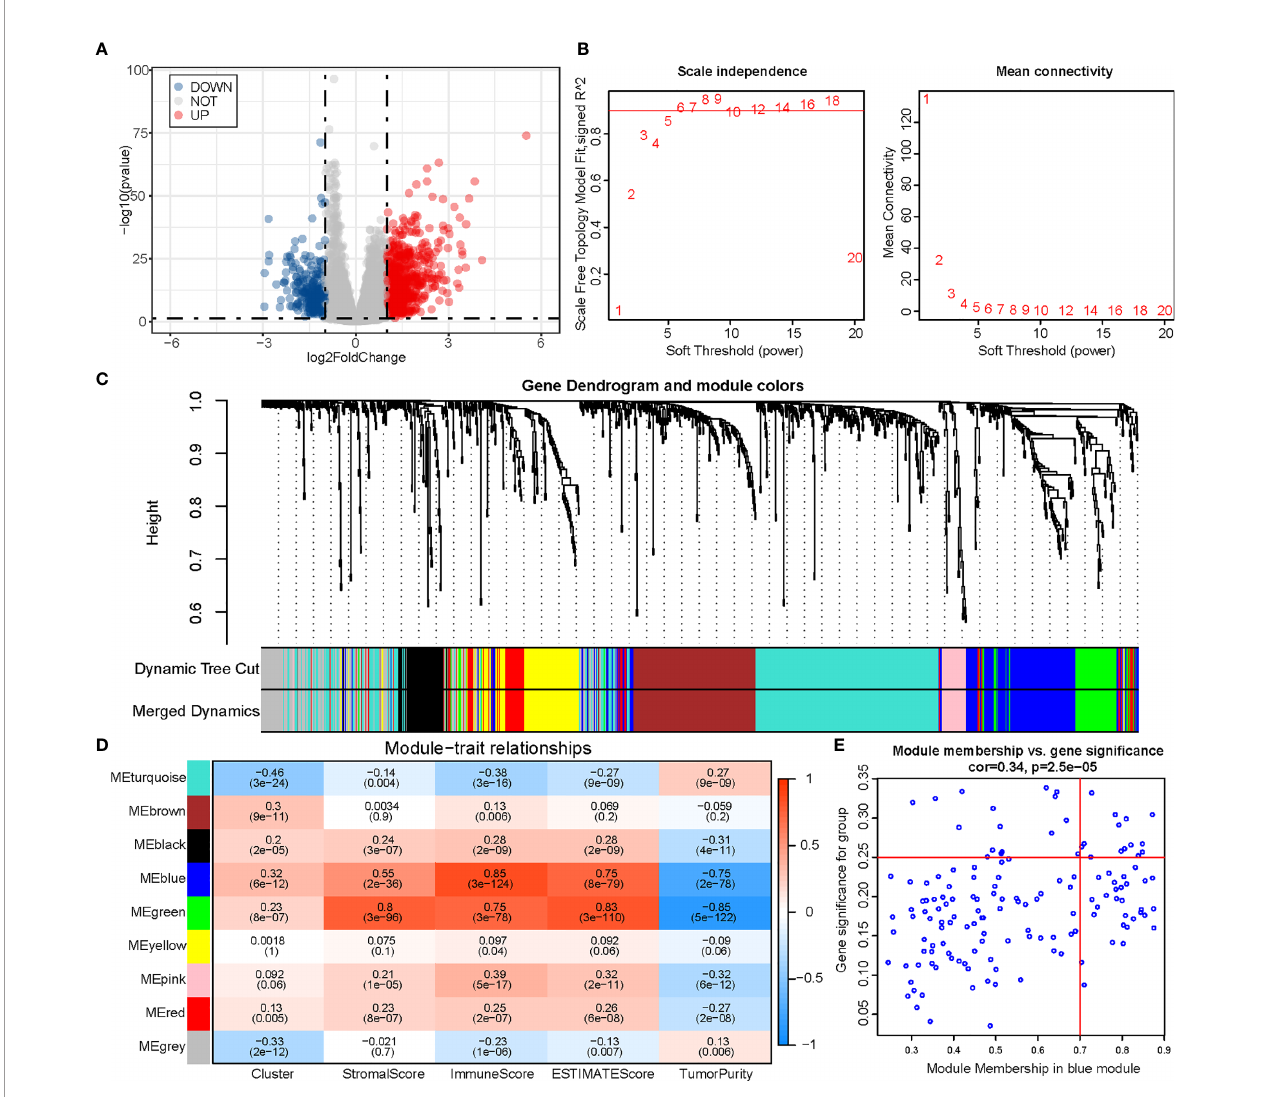
FIGURE 5 | Identi fi cation of module genes associated with both clustering and immunity in the WGCNA. (A) Volcano plot of differential analysis. (B) Analysis of network topology for soft powers. (C) Gene dendrogram and module colors. (D) Heatmap between module eigengenes and cluster, ESTIMATE results. (E) Scatter plot of module eigengenes in the blue